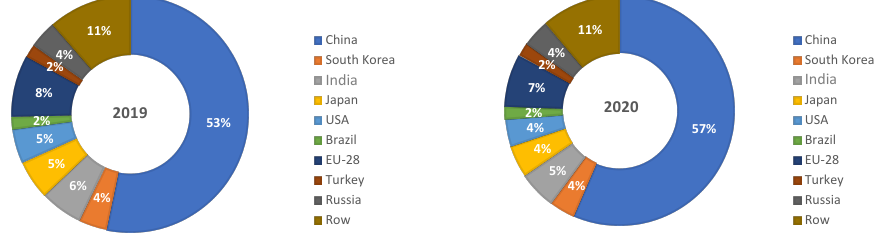
Figure 3. Annual crude steel production for 2019 and 2020; adapted from